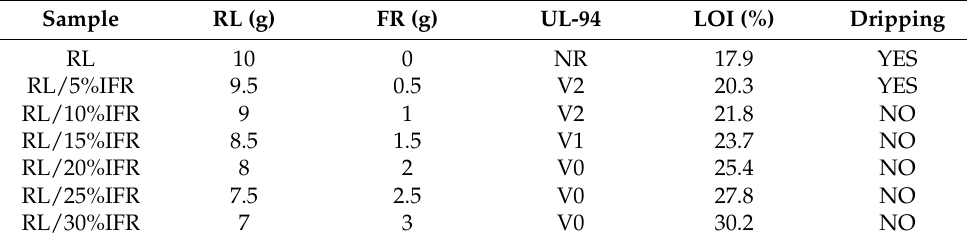
Table 3. Flame retardant properties of lacquer films with different IFR